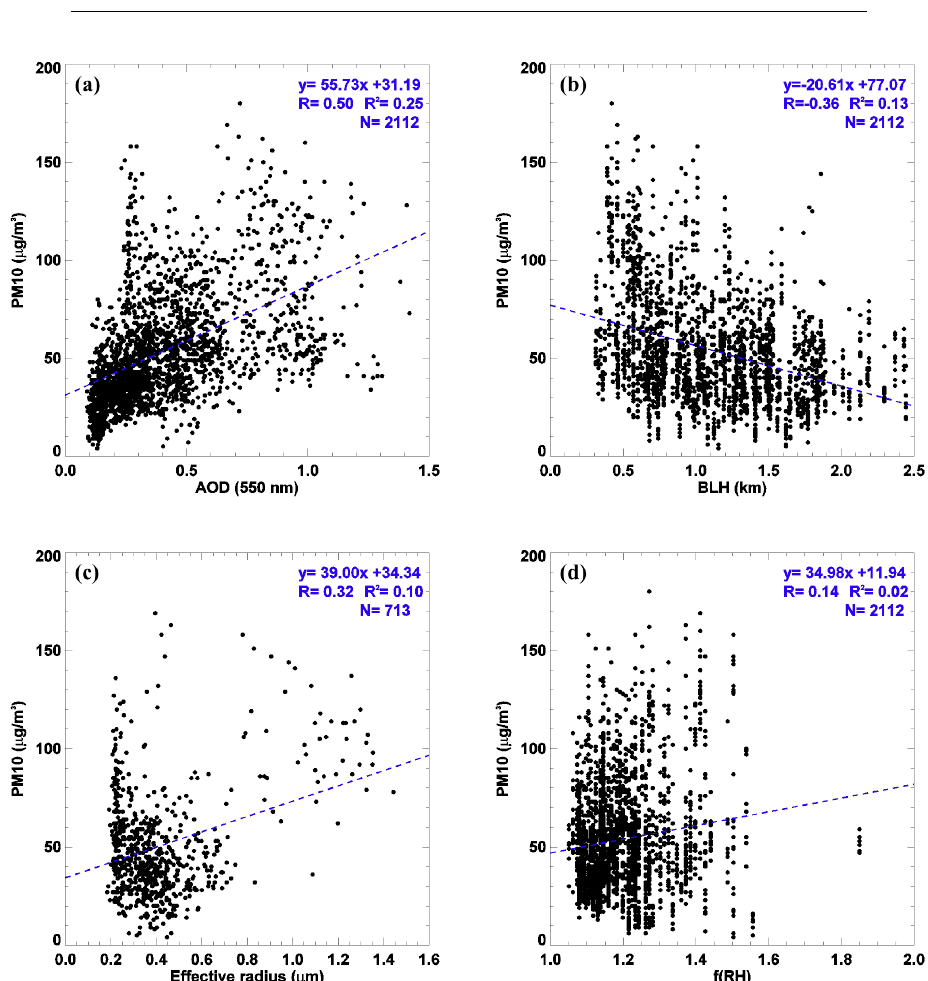
Figure 4. Scatterplots of the various parameters – including (a) AOD, (b) BLH, (c) effective radius, and (d) RH – against the dependent variable of PM 10 concentration. The regression line is shown as a blue dashed